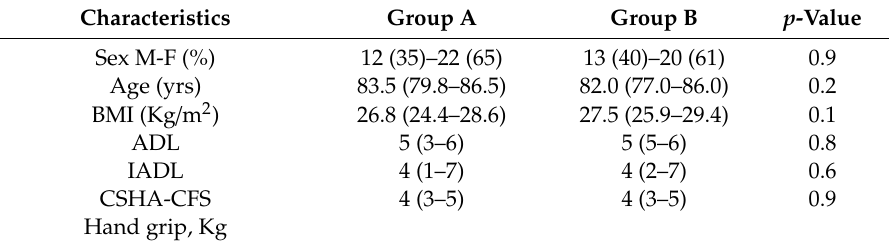
Table 1. Baseline characteristics of participants according to with intervention